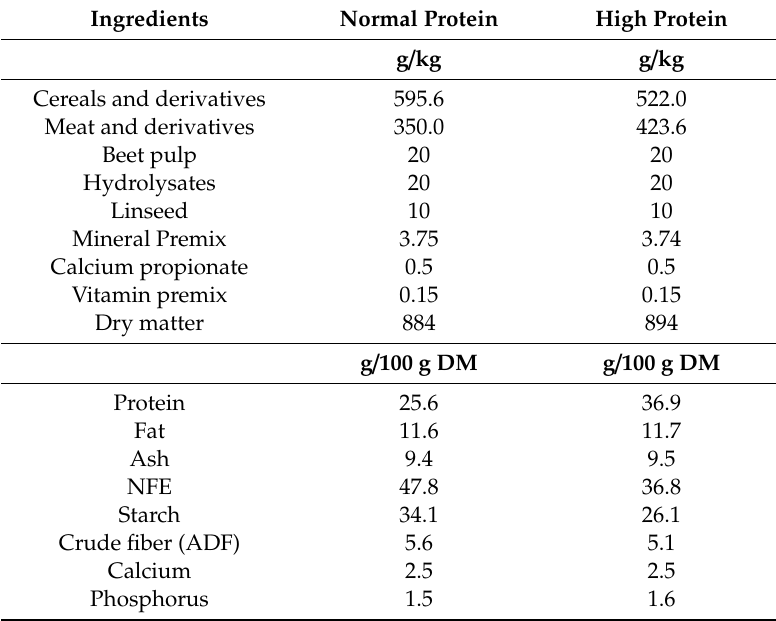
Table 1. Analyzed composition of the basal diets as fed to dogs.